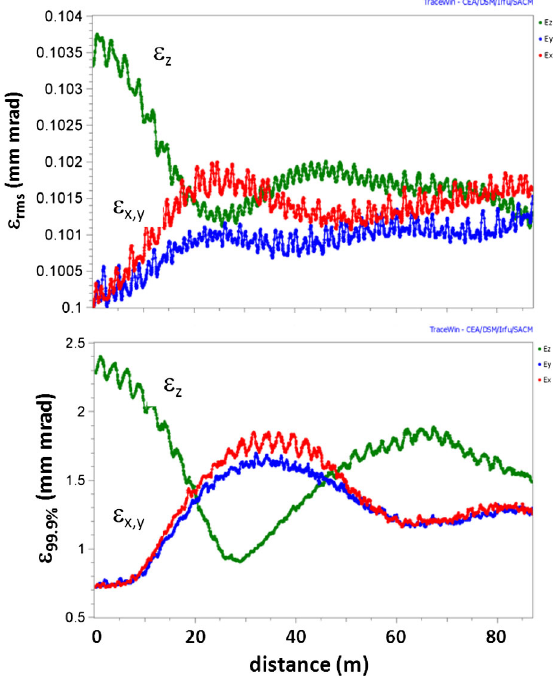
FIG. 9. Static tune with k z 0 =k x 0 ¼ 1 : rms (top) and 99.9% (bottom)